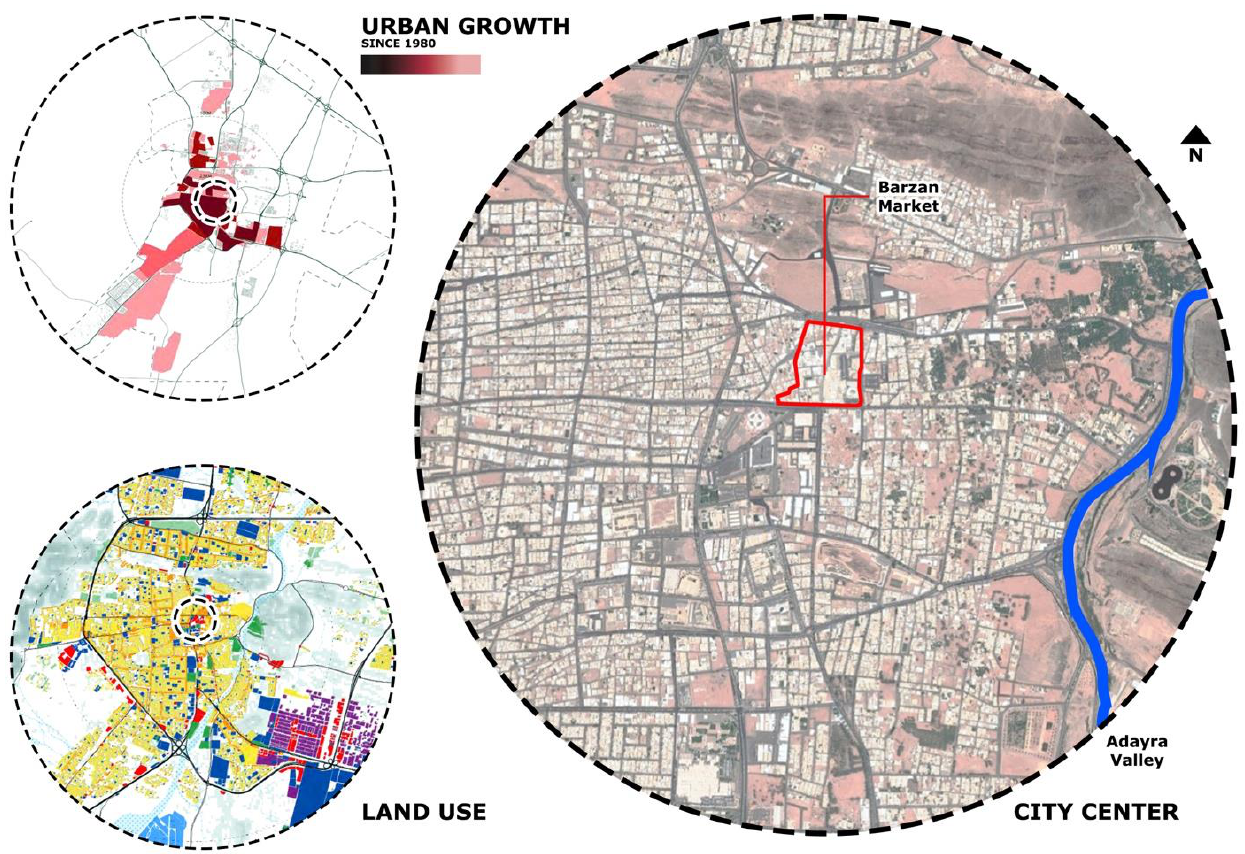
Figure 4. Hail city profile and the location of Barzan Market. Source: Authors.